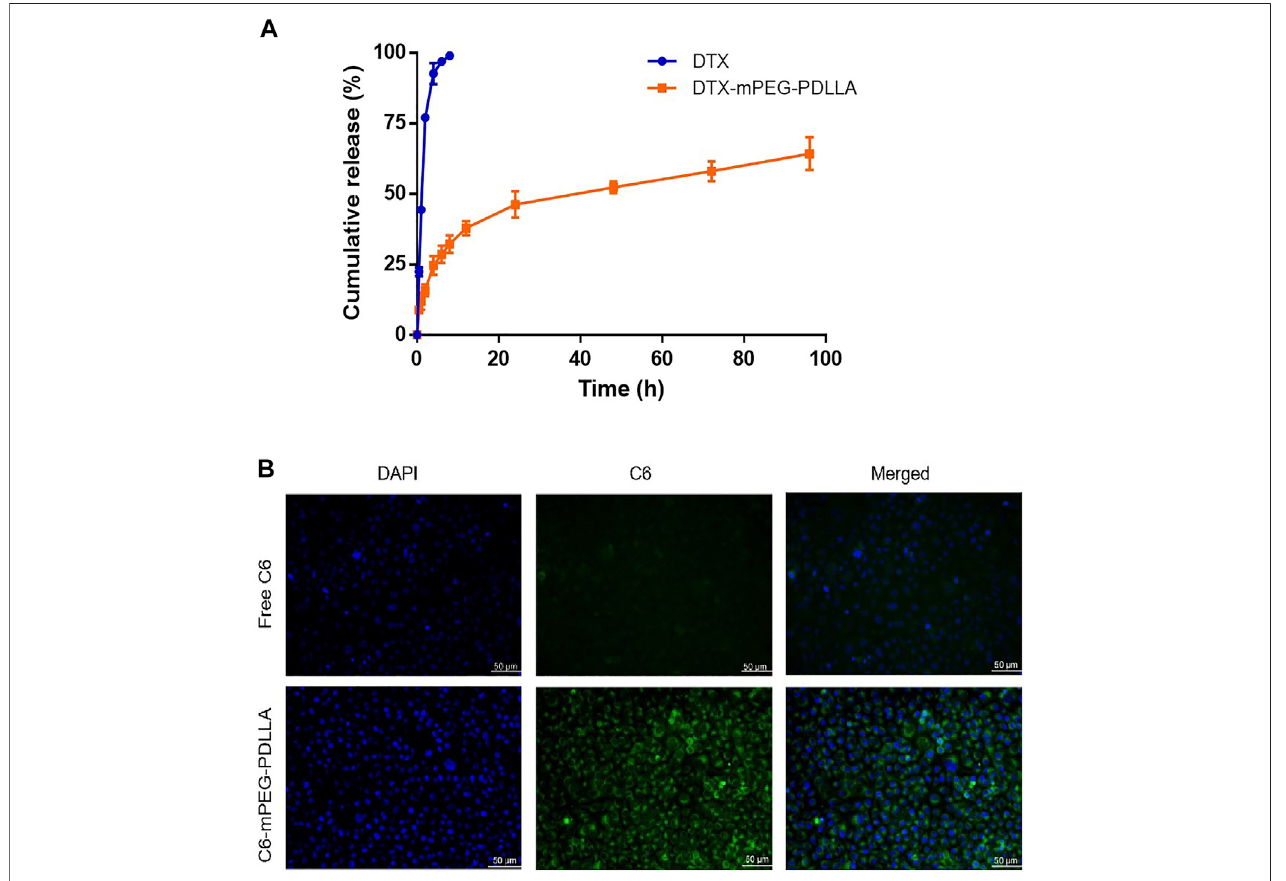
FIGURE 3 | DTX release from DTX-mPEG-PDLLA micelles in vitro and cellular uptake of C6-mPEG-PDLLA micelles. (A) Release characteristics of DTX and DTX- mPEG-PDLLA micelles in vitro . The data were analyzed as mean ± SD ( n = 3). (B) Cellular uptake in SKOV-3 cells.